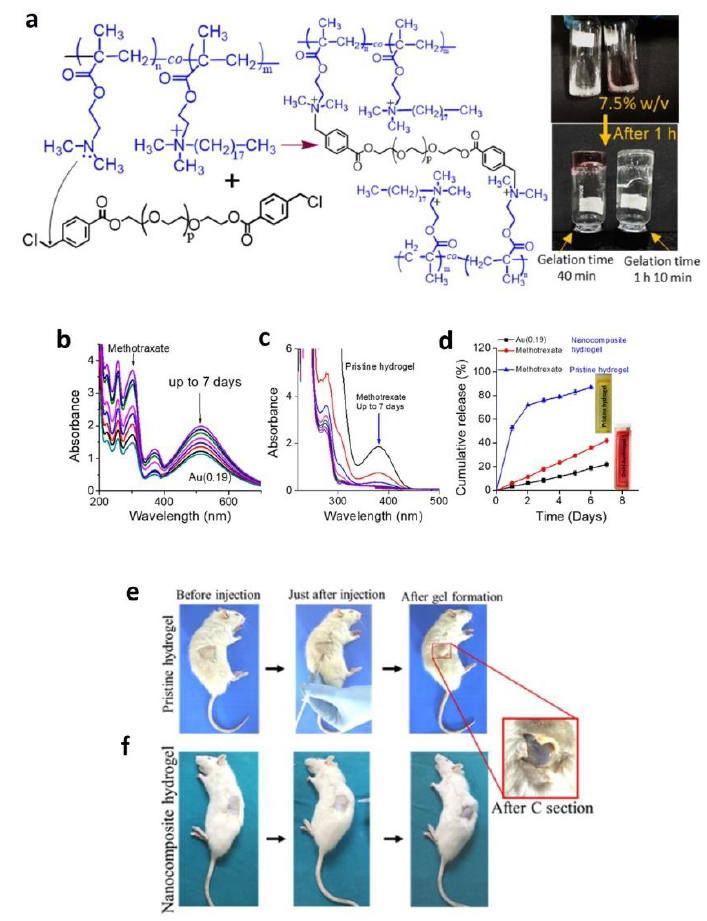
Figure 2. ( a ) Schematic illustration and digital photographs of the hydrogel formation (prepolymer solution = 7.5% w / v ). The vials were inverted after a certain time for recording the photographs. ( b , c ) Lowering of UV-Vis spectra intensity of entrapped methotrexate (MTX) and AuNPs (λmax = 514 nm) with incubation period. ( d ) Cumulative release (%) of MTX and AuNPs with incubation period (at pH 7.4). ( e , f ) Injection of a prepolymer containing no NPs and Au(0.19) NPs [83]. Reprinted with